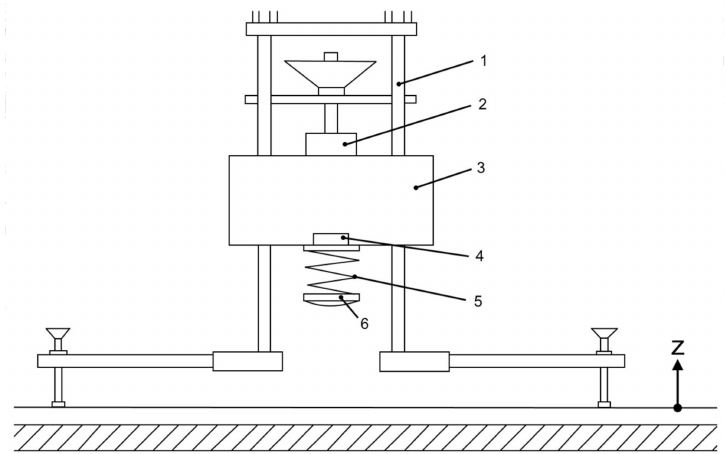
Figure 3. Advanced Artificial Athlete (AAA) schematic: 1. support frame; 2. electric magnet; 3. 20